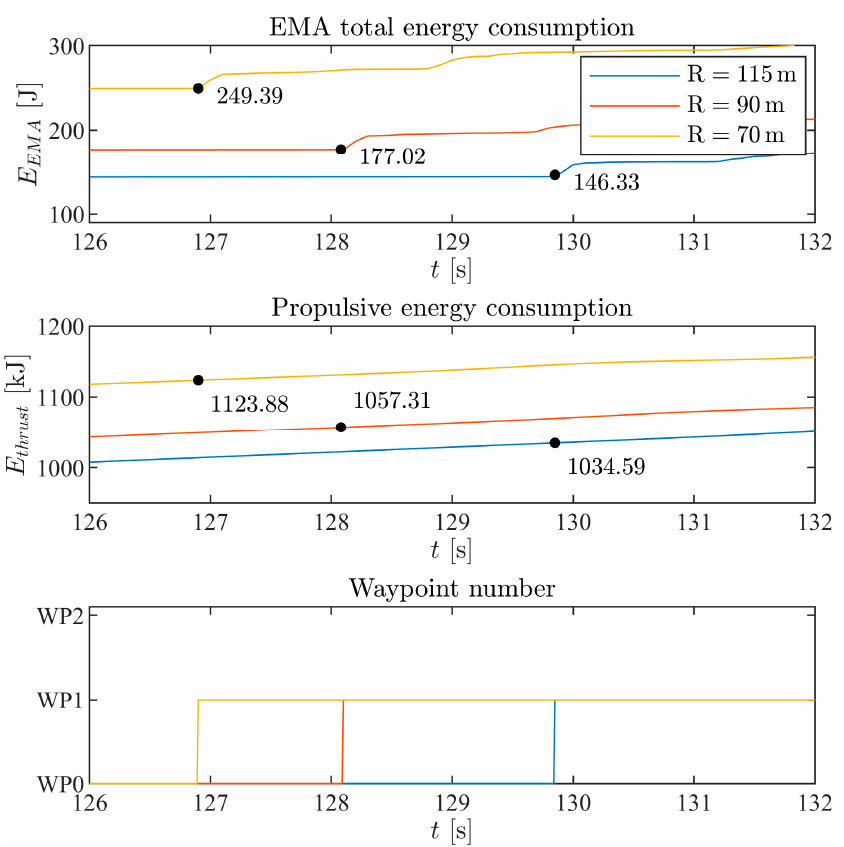
Figure 19. Energy consumption comparison at the same waypoint for the EMA and propulsion units.